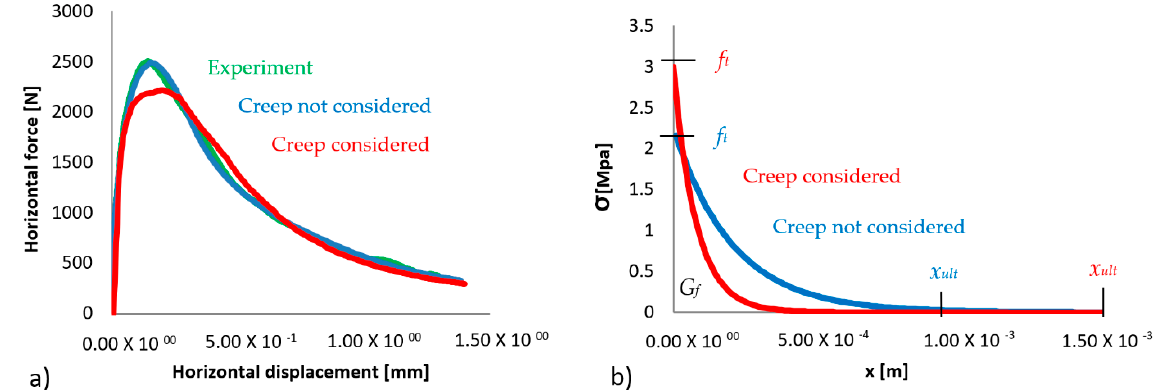
Figure 10. Load-displacement diagram ( a ) and strain-softening behavior ( b ) at 1370 °C.